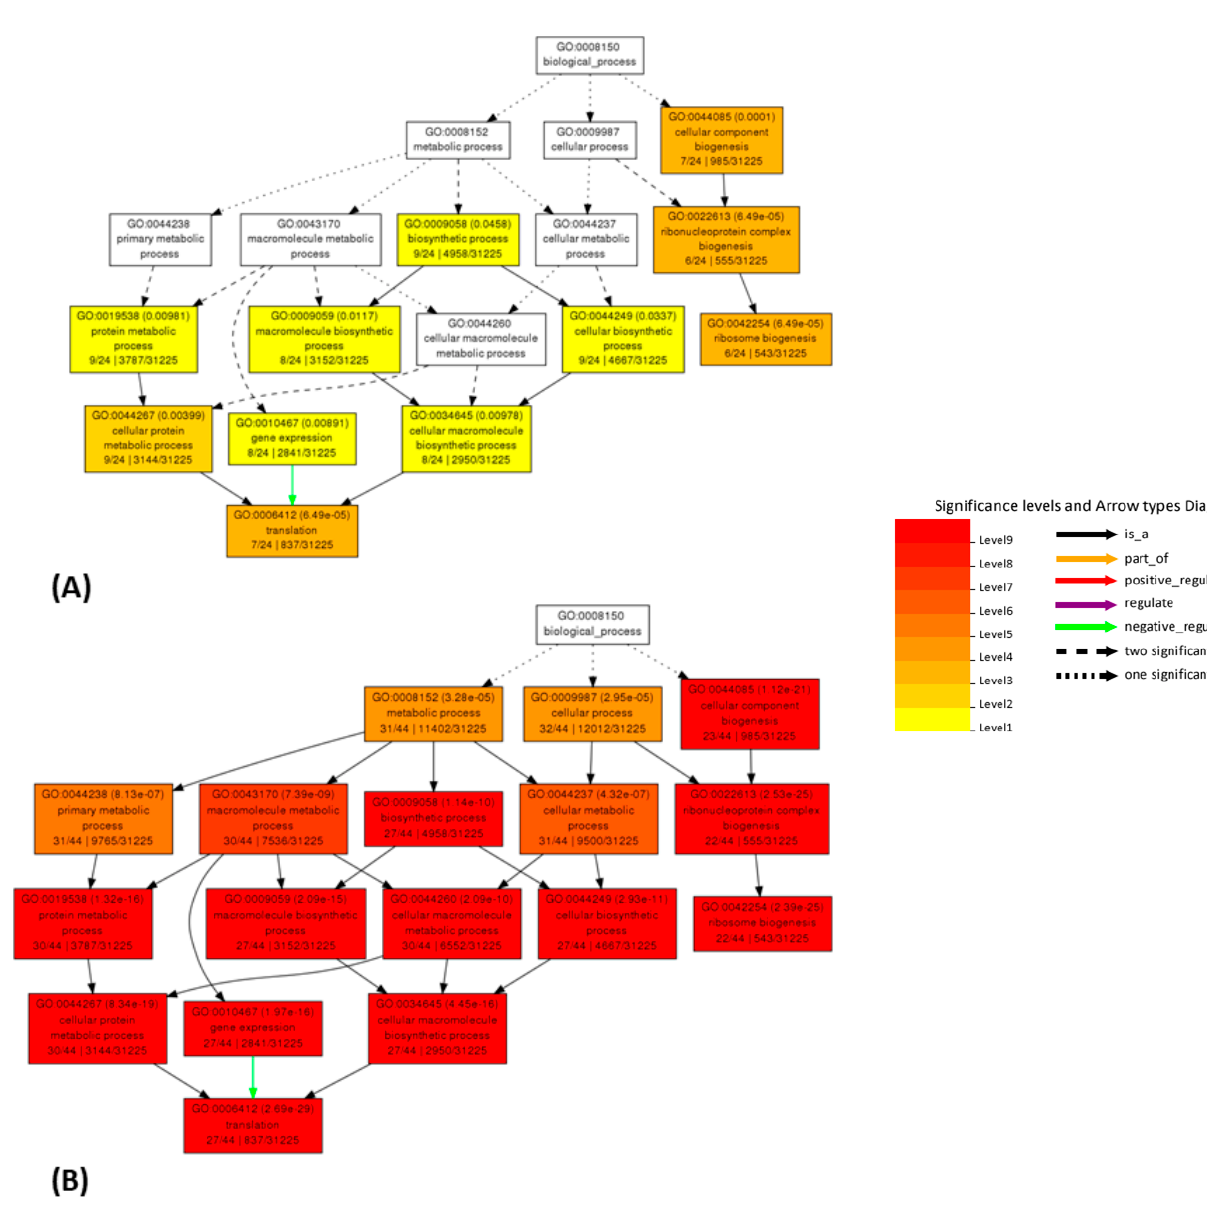
Figure 5. Comparison of AgriGO enrichment analysis working with linear co-expression data for the Mtr.12230.1.S1_at gene (Table S17A). Results obtained from correlation values working on the original ( A ) and cleaned ( B ) dataset.